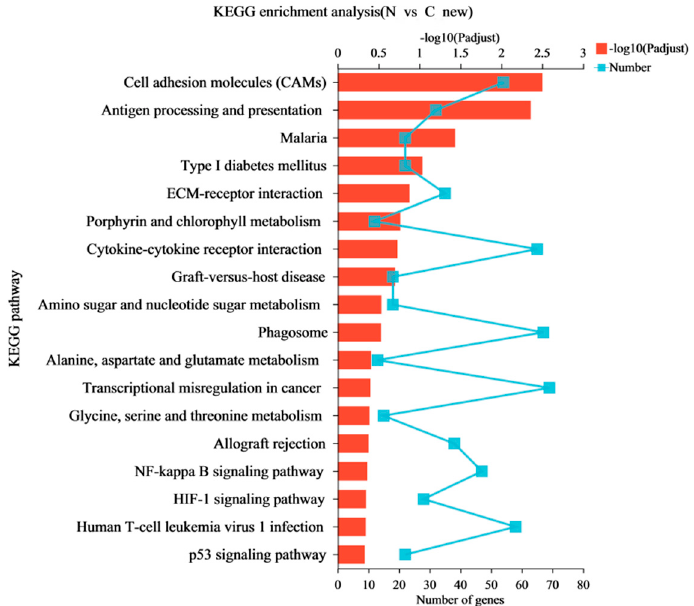
sponding to the bar’s height.